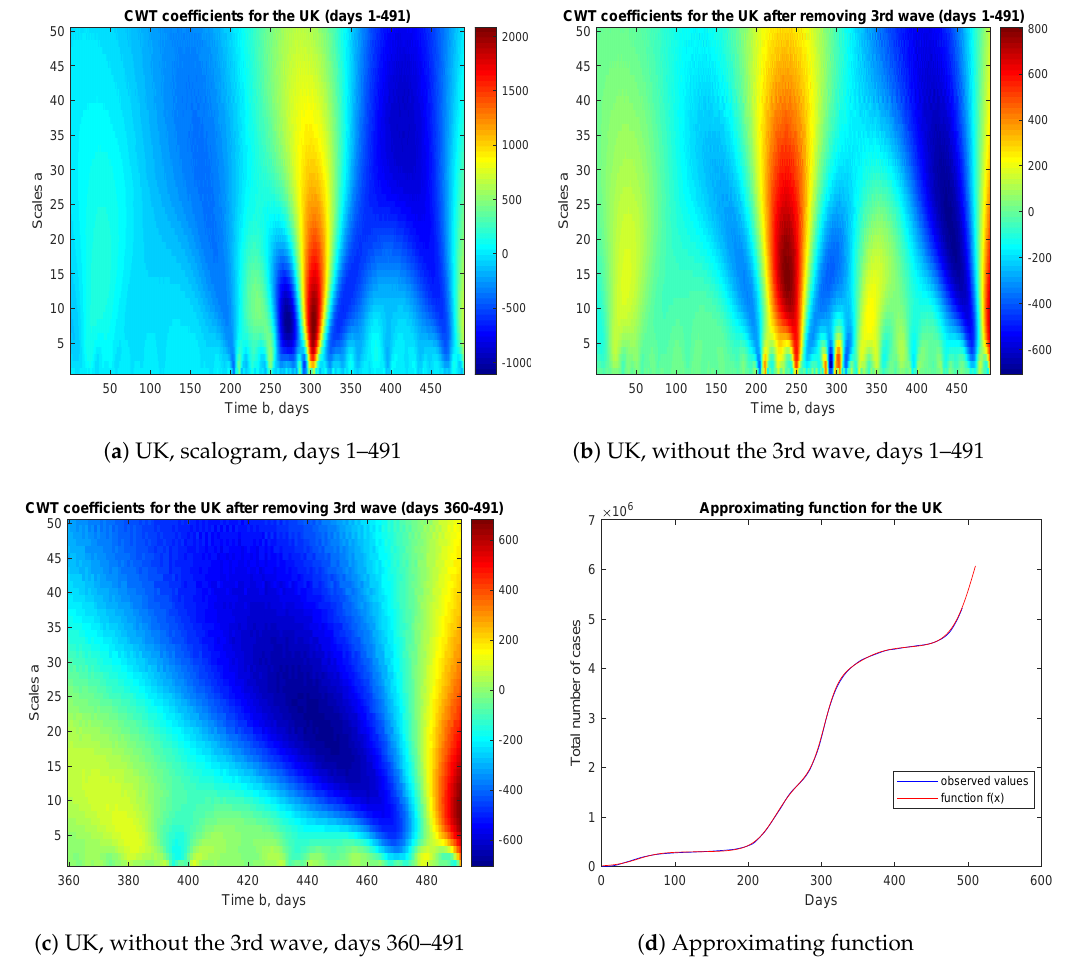
Figure 5. Scalograms and the approximating multilogistic function (26) for the UK. In this case, unlike in previous countries, a new, developing logistic wave is visible on the right in the Figure 5b,c. On July 16 (day 492), this wave has not yet reached its inflection point, as shown by the second differences, which are all positive (Table 2). Table 2. A part of the working table for the UK. Day, n y n ∆ 2 y n . . . . .